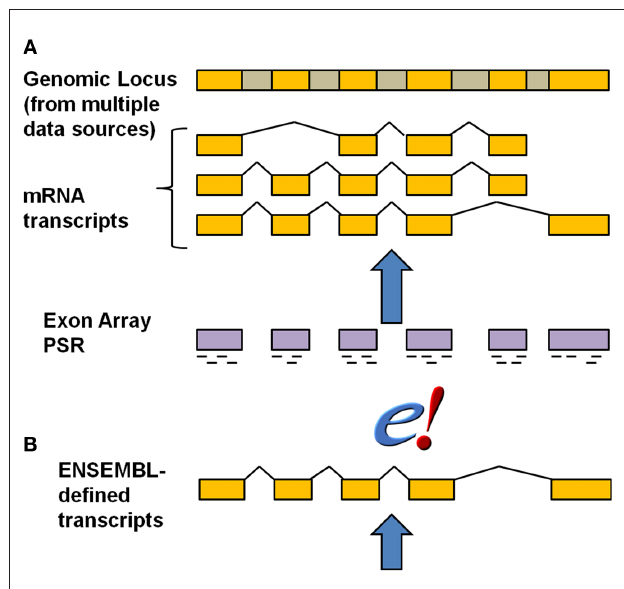
FiguRe 3 | Annotation strategies for exon array probes. The schematic indicates the relationship of gene, transcript and exon structure annotation to probes. Golden regions are exons whereas the gray regions represent introns that are removed during splicing. The short dashes underneath the exon regions for the exon array probe selection region (PSR) indicate individual probes representing that PSR. The default Affymetrix transcript cluster annotation (A) was compared